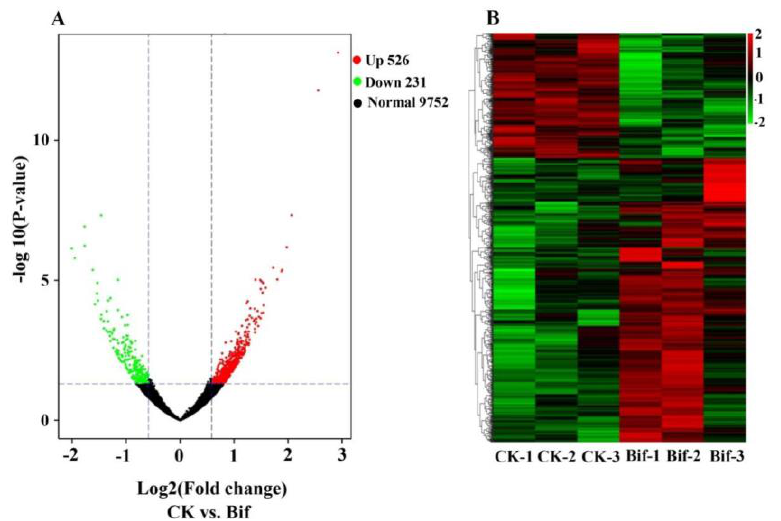
Figure 1. ( A ) Volcano plot of differentially expressed genes (DEGs, |fold change| ≥ 1.5 and FDR < 0.05), and the up-regulated genes were represented by a red dot and down-regulated genes by a green dot. ( B ) Expression profiles (FPKM value) of DEGs. X -axis: sample name, Y -axis: DEGs. The colors indicated the expression levels of DEGs, and red indicated high expression and green indicated low expression.